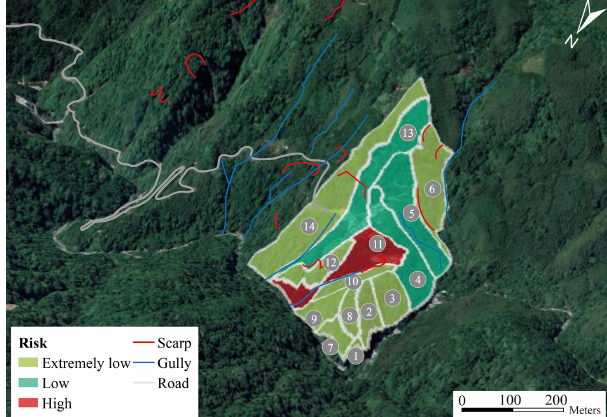
Figure 12. Risk level referring to slope units around the Neikui- hui tribe (background: modified from © Google Earth 2021; aerial: ESRI ArcGIS 10.4).